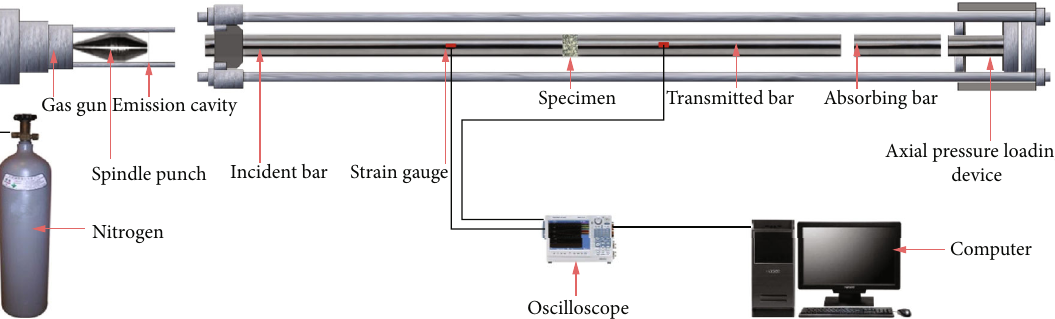
Figure 2: The split Hopkinson pressure bar system.